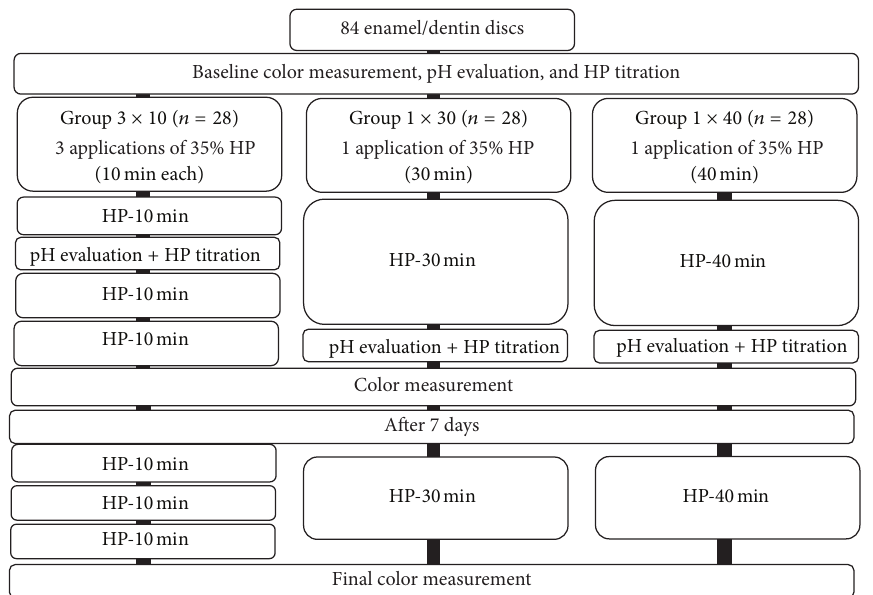
Figure 1: Schematic representation of the design of the study.